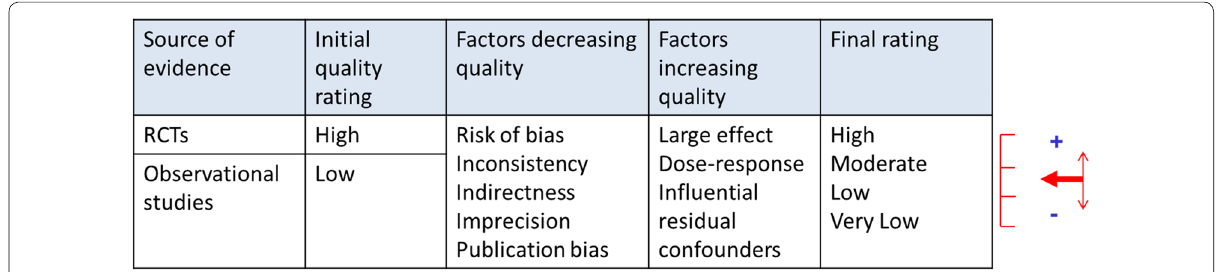
Fig. 1 GRADE assessment of the strength of evidence of individual studies and systematic reviews. Adapted from